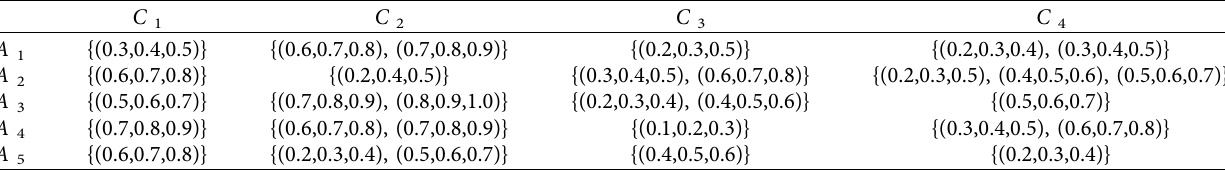
Table 1: Hesitant triangle fuzzy decision matrix.